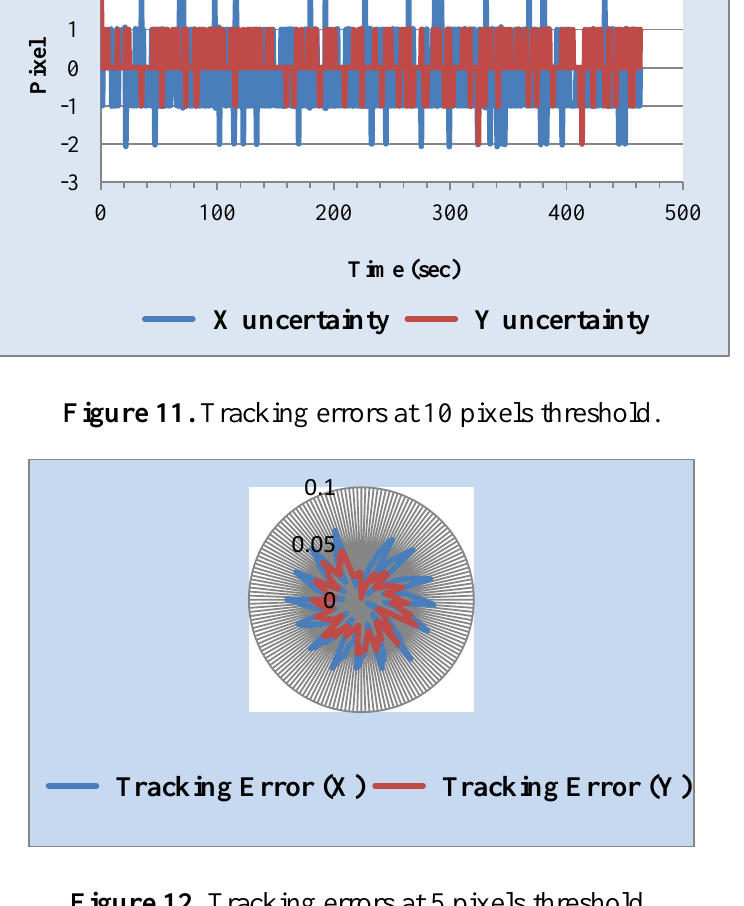
Figure 12. Tracking errors at 5 pixels